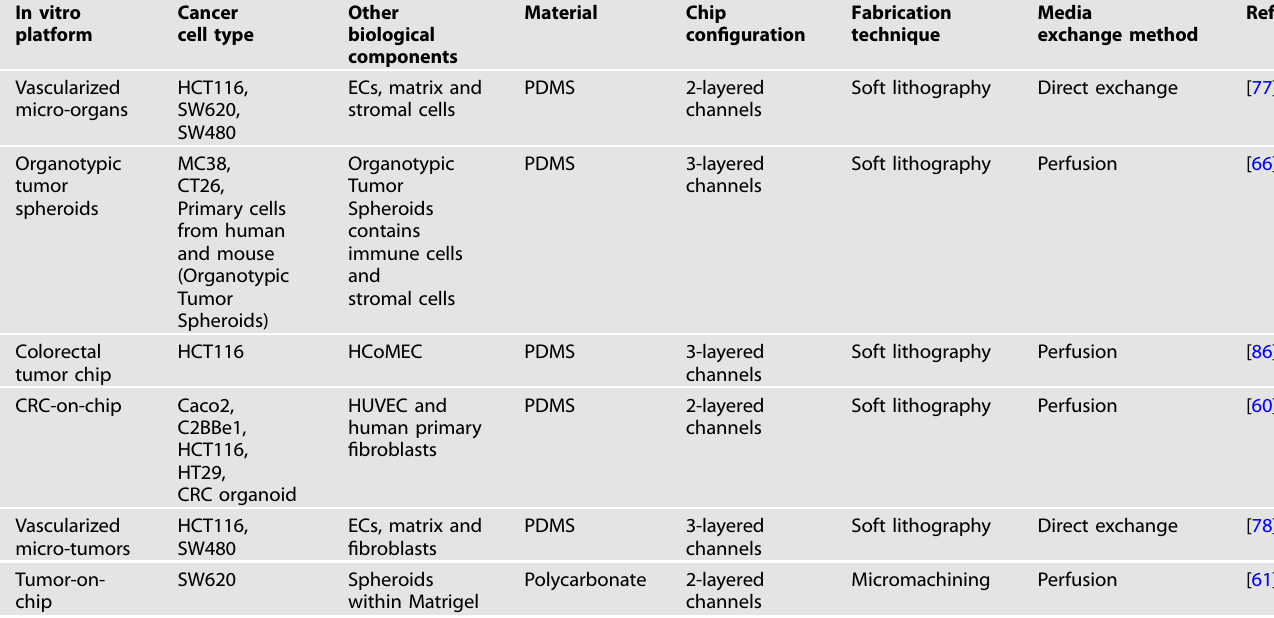
Table 2. Technological overview of organ-on-a-chip models of colorectal cancer. In vitro